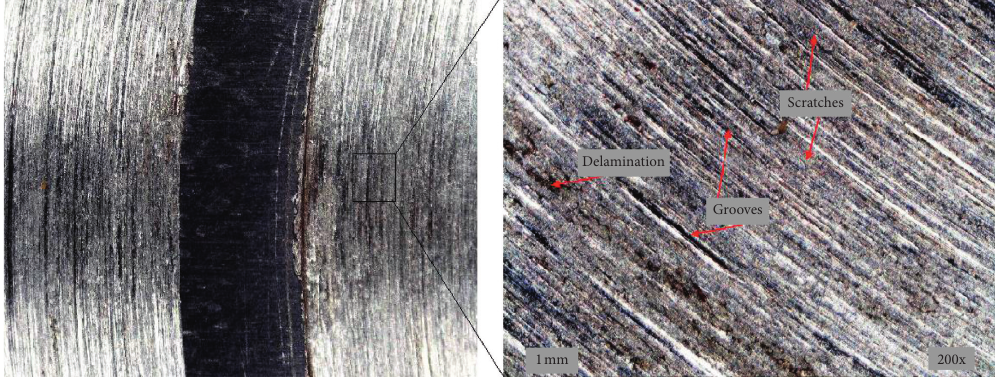
Figure 9: Microscope images of wear tracks. Table 5: Optimum conditions for sliding parameter of AlTiN-coated titanium